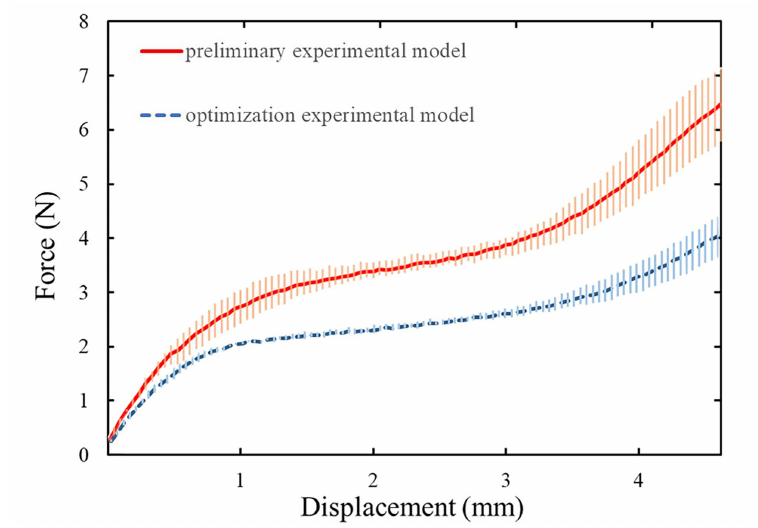
Figure 11. Comparison of the results and error intervals between the preliminary and optimized experimental